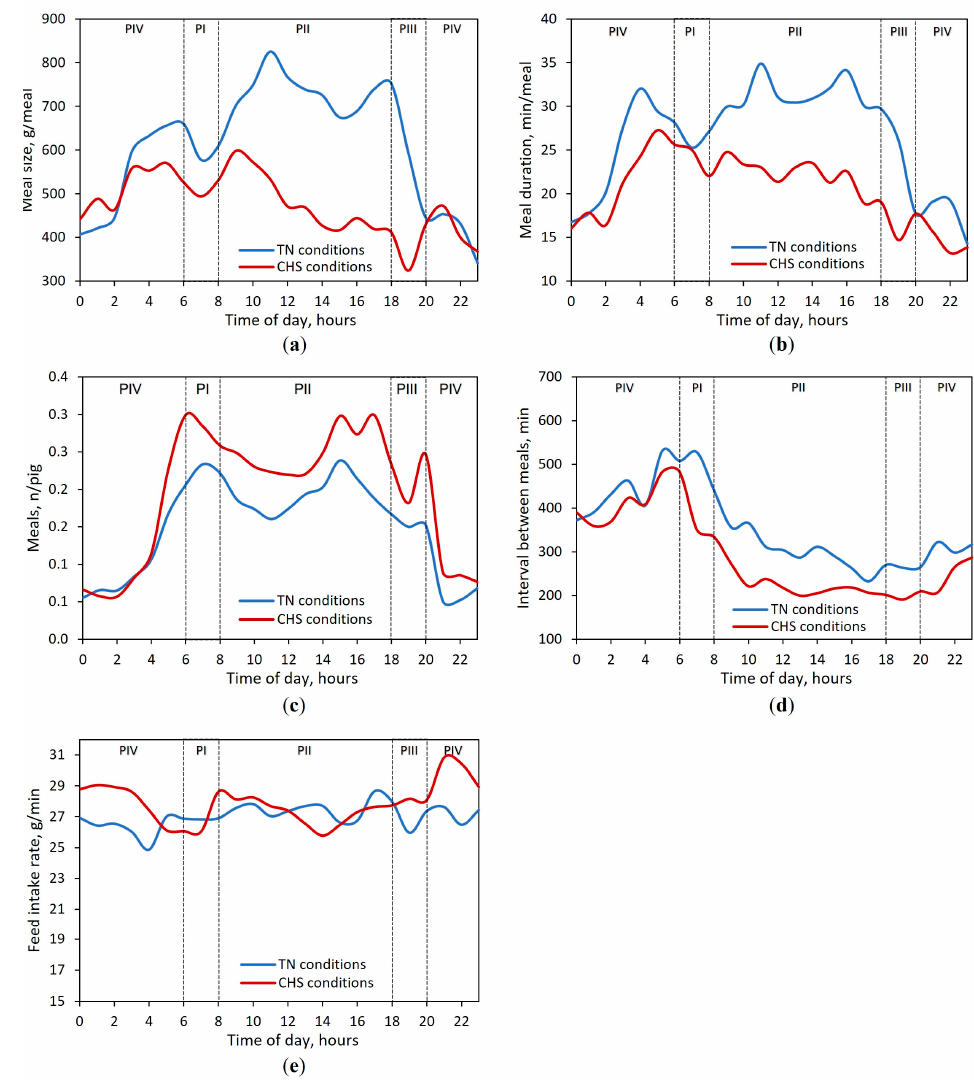
Figure 3. Circadian variation in ( a ) meal size, ( b ) meal duration, ( c ) number of meals, ( d ) interval between meals, and ( e ) feed intake rate for finishing pigs reared in thermoneutrality (TN, 24 h at 22 °C) or cyclic heat stress (CHS, 12 h at 22 °C, 20–08 h, and 12 h at 35 °C, 08–20 h) conditions for 38 days of the experimental period. Periods of the day: PI (06–08 h) ; PII (08–18 h) ; PIII (18–20 h) ; PIV (20–06 h) . Average data of 45 pigs per AT condition throughout 24 h day, regardless of the experimental phase. The lighting program was fixed to 12 h of artificial light (06 to 18